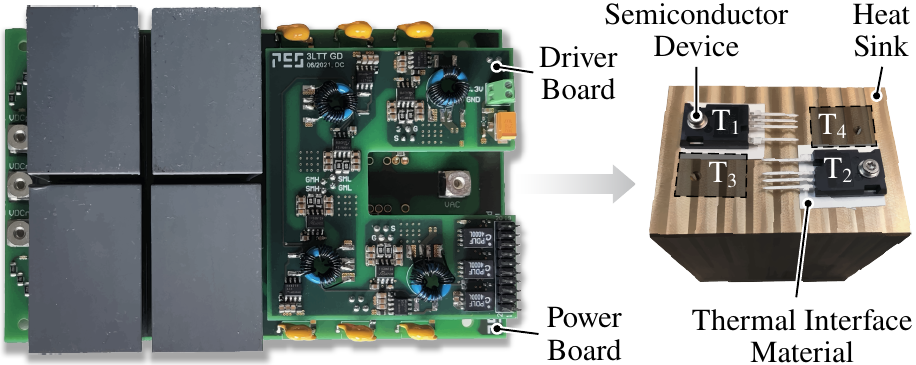
Figure 3. Overview of the 3LTTC bridge-leg test board and brass heat sink used for calorimetric loss